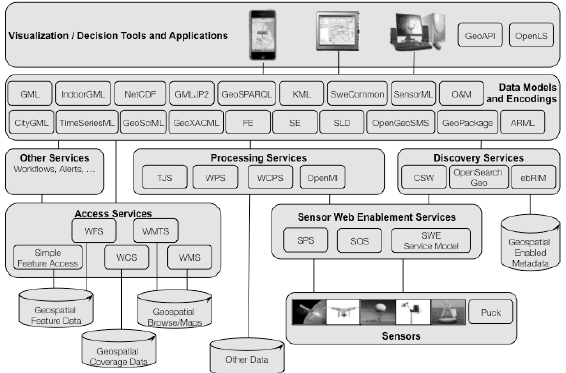
Figure 1. OGC Standards for Remote